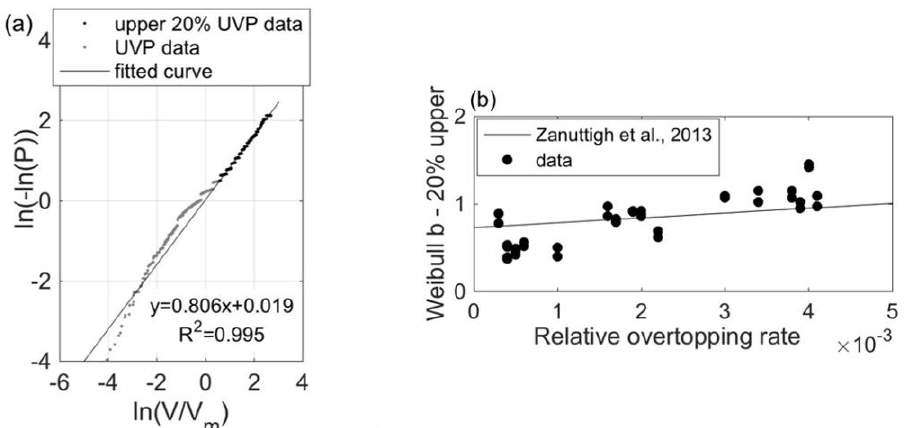
Figure 10. ( a ) Twenty percent exceedance probability distribution of V for an example of test with R c / H s = + 1 and cot( α o ff ) = 2. ( b ) Comparison between Weibull b -values derived from [72] and threshold probability distributions of individual volumes as derived from UVP dataset of all the performed tests.